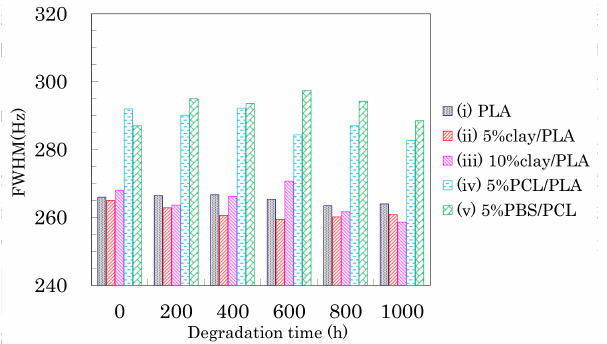
Figure 10. FWHM of CH signal from 4 DR PLA fibers plotted versus degradation